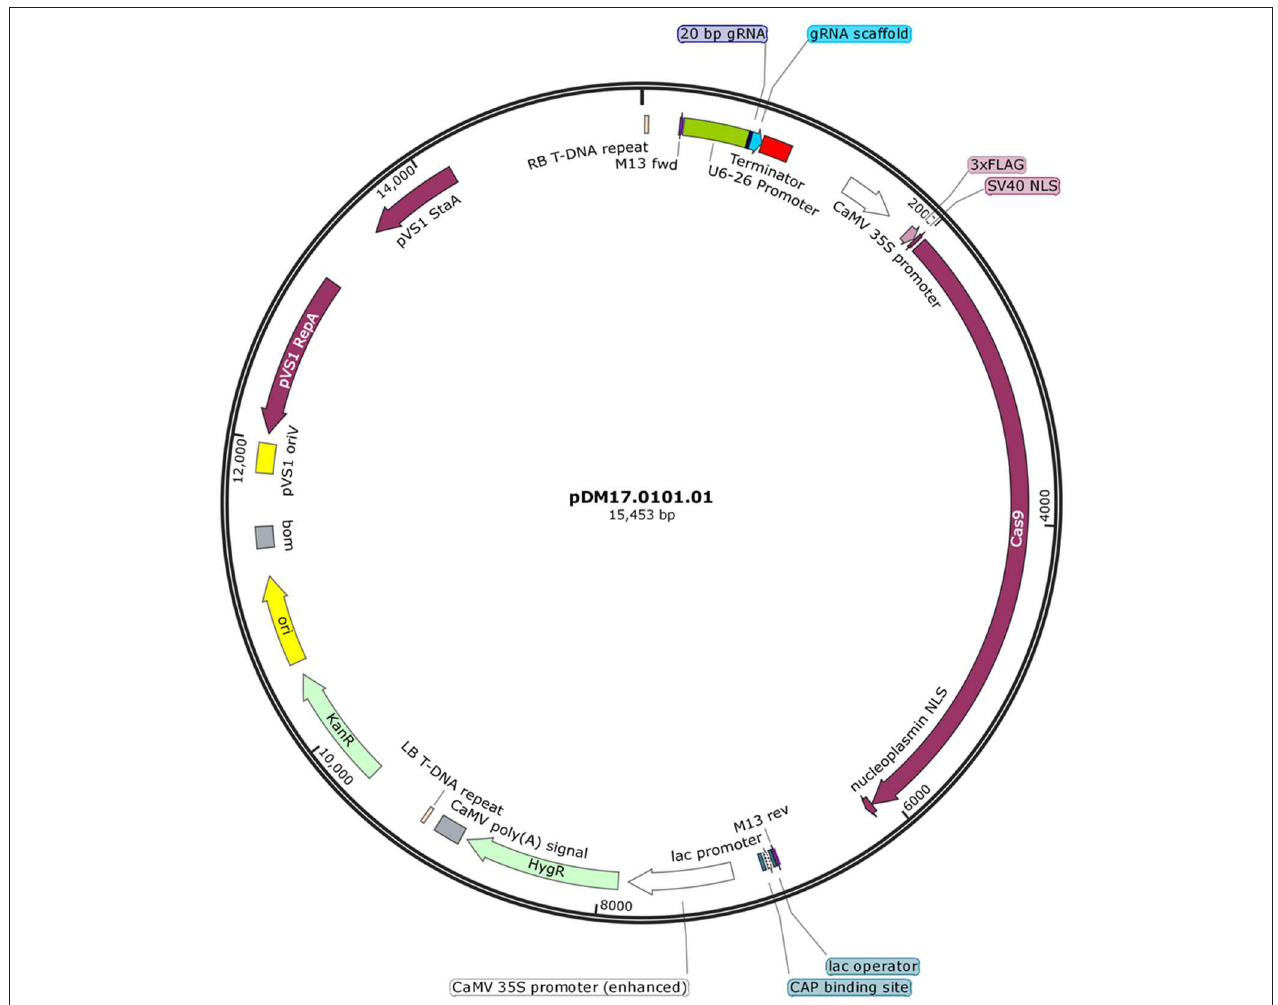
FIGURE 1 | DNA vector used to deliver Cas9 and sgRNA targeting JrPDS . Binary vector for generation of mutant plant lines carrying a construct expressing the sgRNA controlled by the U6-26 promoter and another expressing SpCas9 containing a nuclear localization signal and a